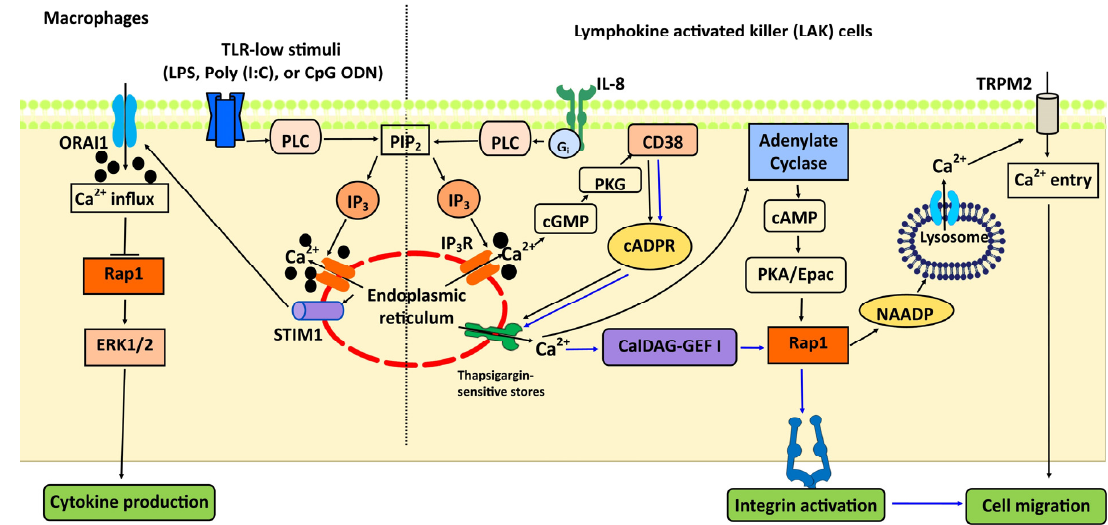
Figure 3. Rap1 and Ca 2 + -cross-talk in immune cells. Ca 2 + signal upstream from Rap1 either inhibits or activates it, eliciting di ff erent responses in immune system. In macrophages (to the left of the dotted line), low doses of TLR agonists trigger signaling which induces Ca 2+ release from ER and oligomerization of stromal interaction molecule 1 (STIM1), leading to the opening of the plasma membrane Ca 2 + release-activated Ca 2+ channel protein (ORAI1) channels and Ca 2+ influx, which subsequently causes Rap1 inhibition and ERK activation to induce cytokine production. In lymphokine activated killer (LAK) cells (to the right of the dotted line), CD38 activation, downstream from the IL8 receptor, induces cyclic ADP-ribose (cADPR) production, enhancing Ca 2+ release from thapsigargin-sensitive stores (blue lines), which promotes the activation of adenylyl cyclase. Downstream, cAMP-activated Epac / Rap1 induce nicotinic acid adenine dinucleotide phosphate (NAADP) production, resulting in CICR through TRPM2 channel, promoting cell migration.